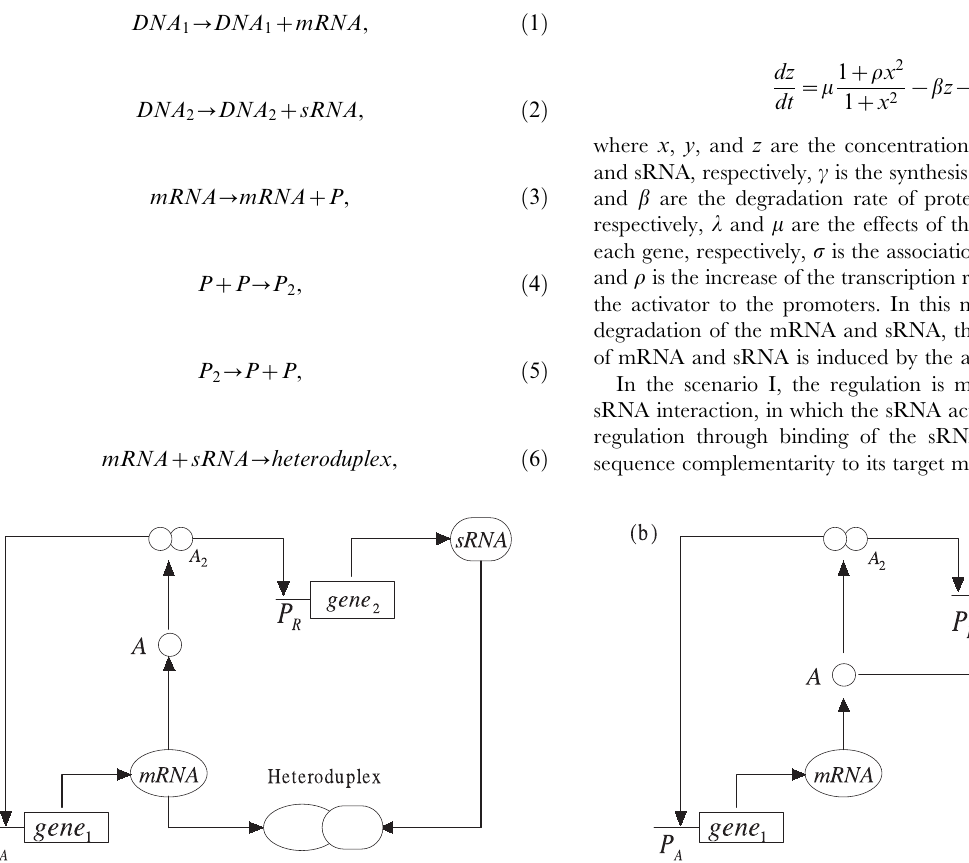
Figure 1. Schematic description of the two scenarios. (a) Scenario I: post-transcriptional regulation by binding of a sRNA and an mRNA. (b) Scenario II: translational repression by binding of a sRNA and a protein causes inactivation of the protein.